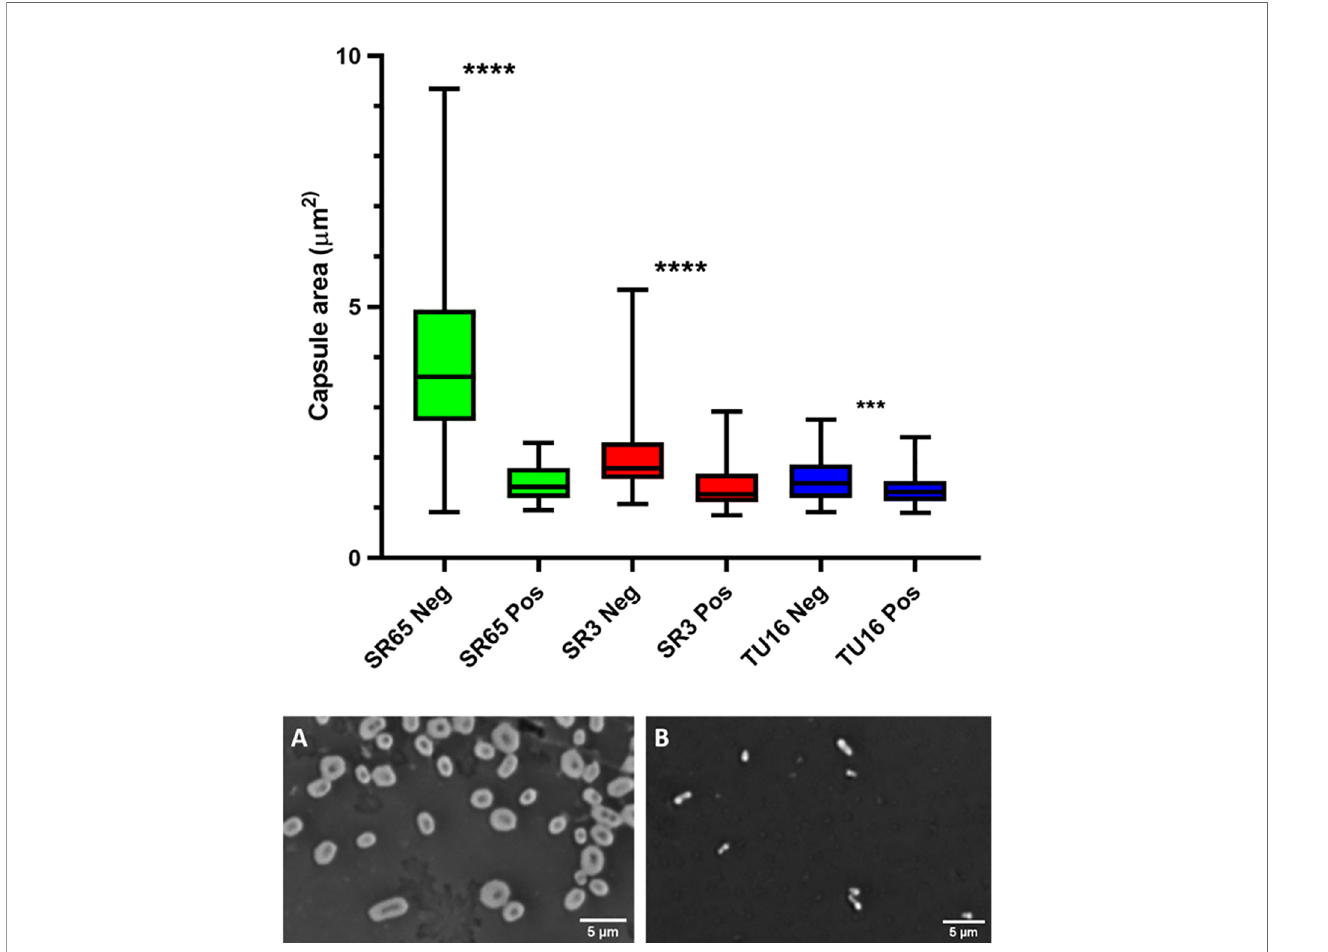
FIGURE 5 | Box and whiskers plot of the impact on capsules of the target K . pneumoniae isolates SR65 (K1), SR3 (K2) and TU16 (K51) following 90 min incubation at 37°C with the corresponding K1, K2 and K51 depolymerases. SR65 Neg, negative control (PBS incubation), n = 319, mean capsule area m m 2 3.41 ± 1.00 (Mean ± 1SD); SR65 Pos, K1 depolymerase-exposed, n = 74, 1.49 ± 0.34; SR3 Neg, n = 119, 1.96 ± 0.58; SR3 Pos, n = 66, 1.41 ± 0.42; TU16 Neg, n = 84, 1.54 ± 0.42; TU16 Pos, n = 170, 1.36 ± 0.31. **** P = < 0.0001, *** P = < 0.002 (unpaired t-test with Welch ’ s correction between treated and untreated groups). Also shown: phase contrast microscopy images of nigrosin staining for isolate SR65 (K1) after 90 min incubation in PBS (A) and with K1 depolymerase (B) . Capsule can be seen in (A) as a bright halo around the